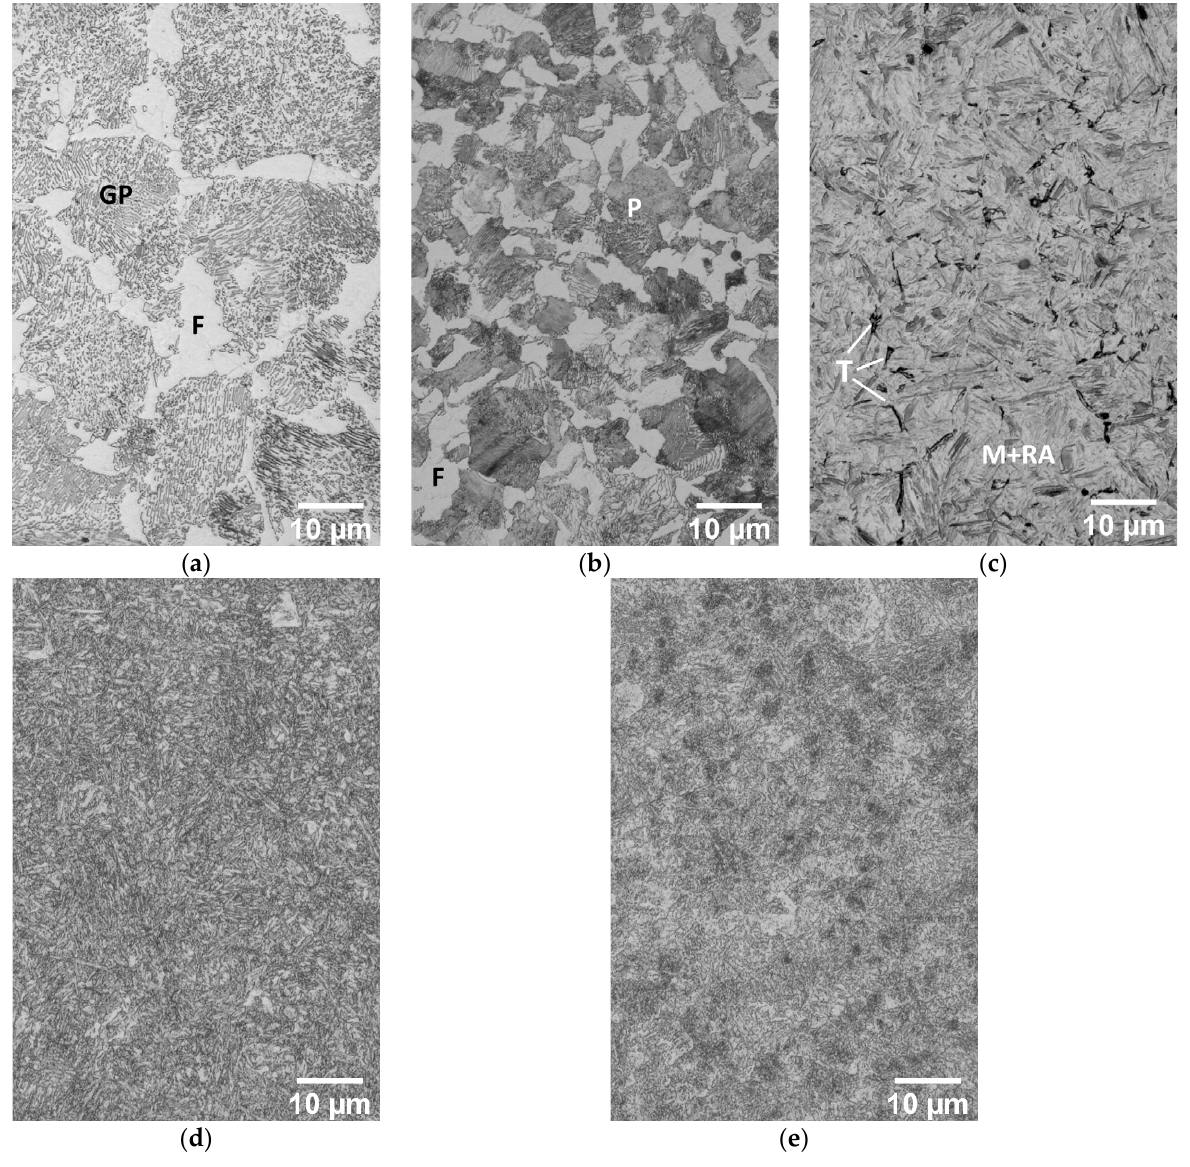
Figure 2. Microstructures of heat-treated samples: ( a ) soft annealed; ( b ) normalized; ( c ) hardened; ( d ) quenched and tempered at 530 °C; ( e ) quenched and tempered at 660 °C (labeling: GP = grained pearlite; F = Ferrite; P = pearlite; T = troostite; M = martensite; RA = retained austenite).